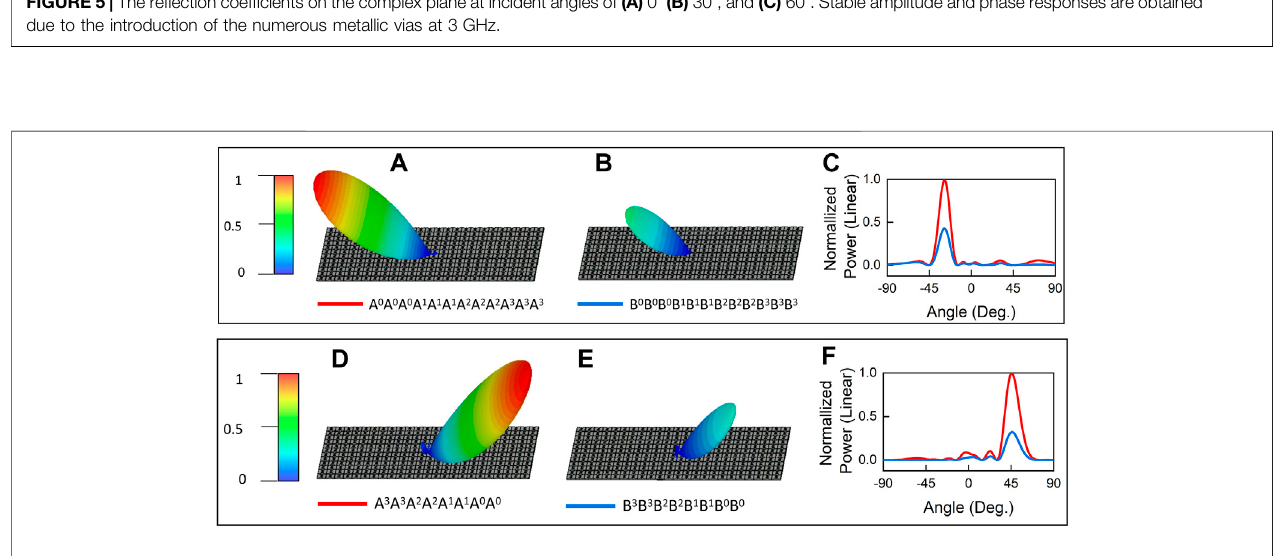
FIGURE 6 | The 3D scattering patterns of coding sequences (A) “ A 0 A 0 A 0 A 1 A 1 A 1 A 2 A 2 A 2 A 3 A 3 A 3 ... ” (B) “ B 0 B 0 B 0 B 1 B 1 B 1 B 2 B 2 B 2 B 3 B 3 B 3 ... ” (D)